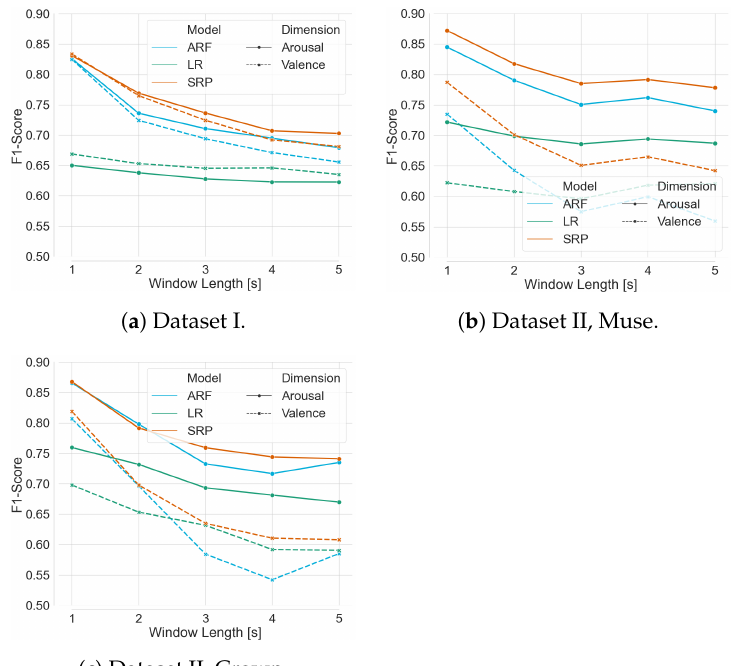
Figure 10. Mean F1-Score achieved by ARF, SRP, and LR over the whole dataset for both affect dimension with respect to window